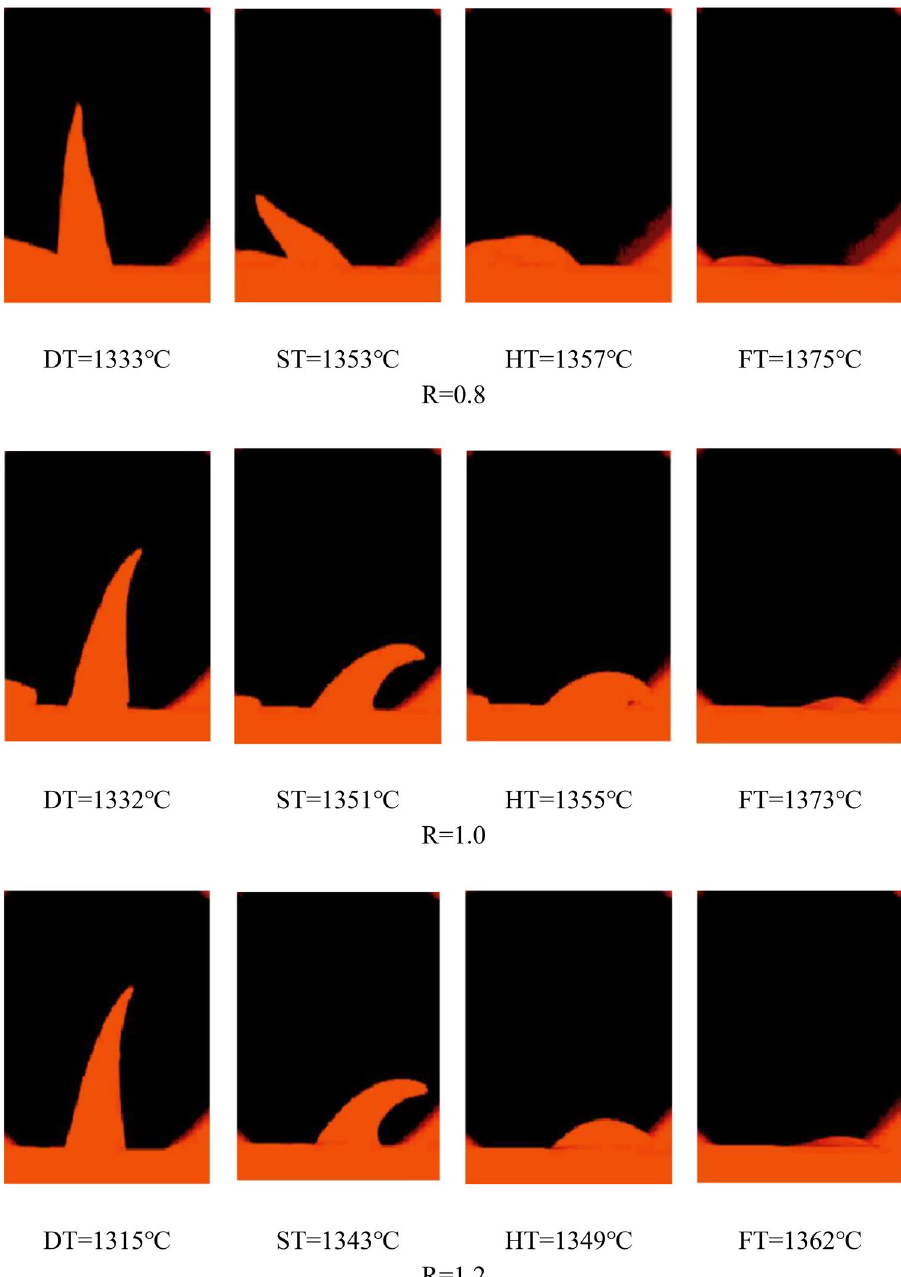
Figure 2. The effect of basicity on melting temperature of